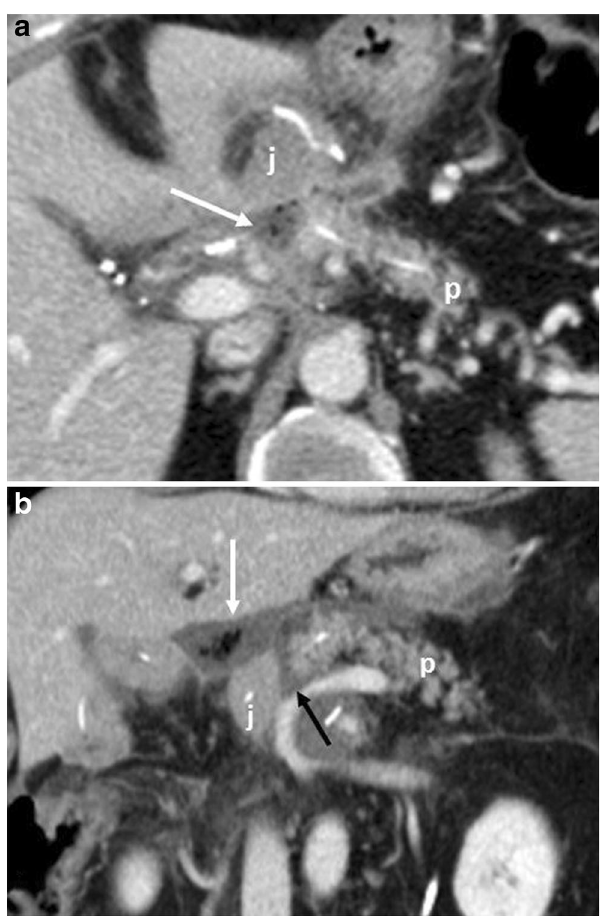
Fig. 14 Pancreatic fistula. a , b Multiplanar CT images. The pancreatic stump (p) and jejunal loop (j) are visualised. A complete disruption of the pancreatic anastomosis is evident (black arrow in b ). At the level of the anastomosis a fluid collection with multiple air bubbles inside is visible (white arrows), a finding that strongly suggests the presence of a pancreatic